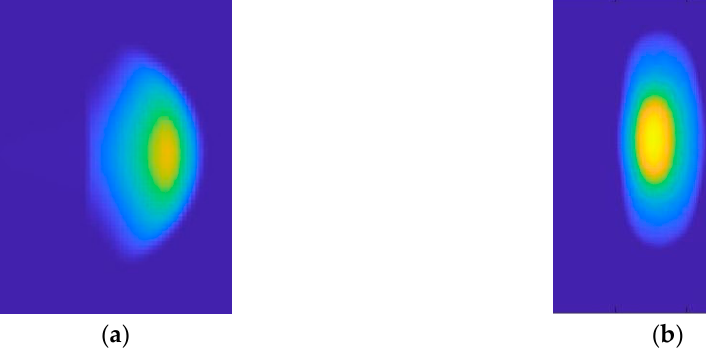
Figure 2. Numerical simulation results of the ping-pong ball experiments. The flow direction is from left to right. Deposit shape predicted by ( a ) the I -dependent model with δ 2 = 30 ◦ and δ S = 20 ◦ ; ( b ) Titan2D with φ int = 30 ◦ and φ bed = 20 ◦